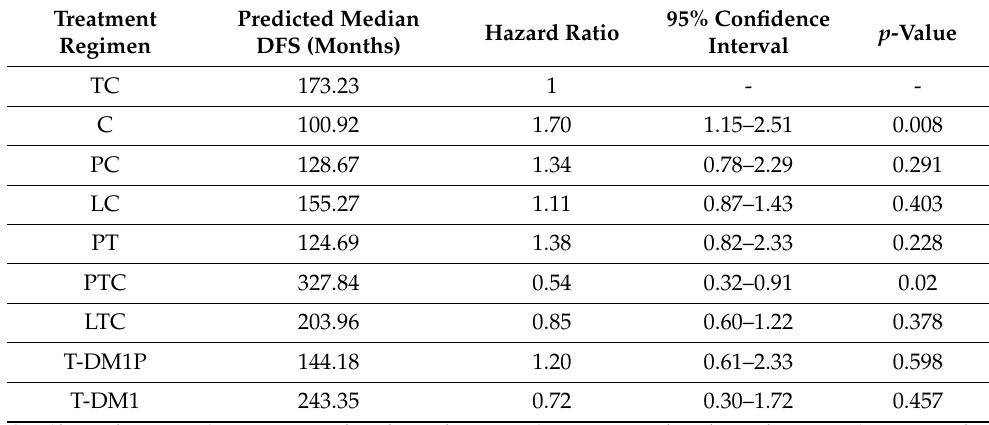
C = Chemotherapy; TC = Trastuzumab + chemotherapy; PC = Pertuzumab + chemotherapy; LC = Lapatinib + chemotherapy; PTC = Pertuzumab + trastuzumab + chemotherapy; LTC = Lapatinib + trastuzumab +chemotherapy; PT = Pertuzumab + trastuzumab; T-DM1P = trastuzumab emtansine + pertuzumab; T-DM1 = Trastuzumab emtansine.